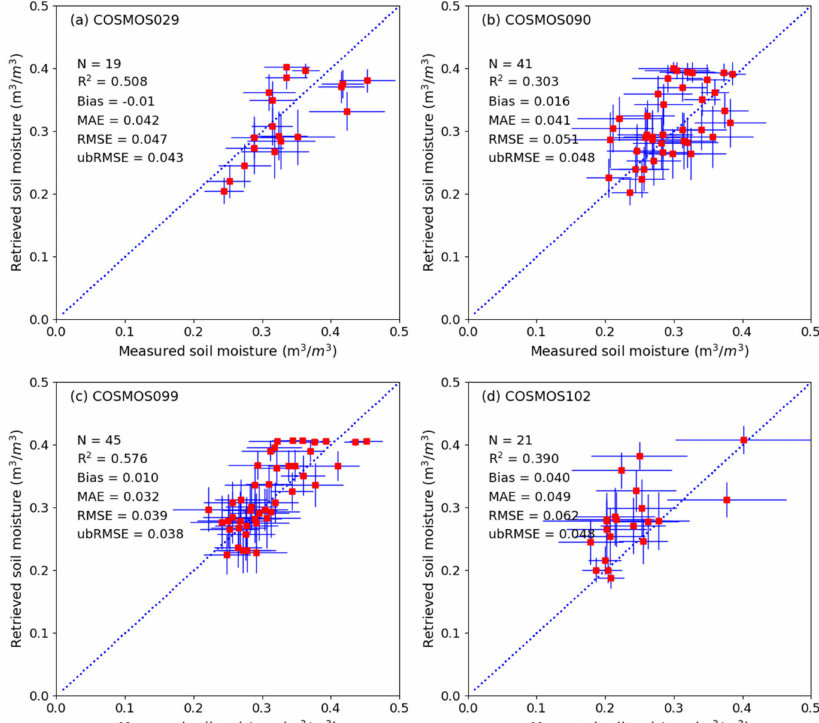
Figure 8. Soil moisture retrievals from the SCA-VV scheme using the calculate-then-average strategy, plotted against measurements from the four COSMOS sites. The vertical error bars represent the root mean standard deviation (RMSD, centered over the mean value of the retrievals at pixel scale) of all pixel’s values within COSMOS footprint, which can be regarded as the spatial variabilities of the retrievals. The horizontal error bars represent the root mean standard error at Sentinel pixel scale (RMSEp, errors in pixel scale retrievals centered over the COSMOS measurement) of the retrievals. Thetext‘RMSE’showninFigureistherootmeanstandarderroratCOSMOSfootprintscale. Thedetailed interpretation regarding the terms RMSD, RMSEp and RMSE can be seen at the context